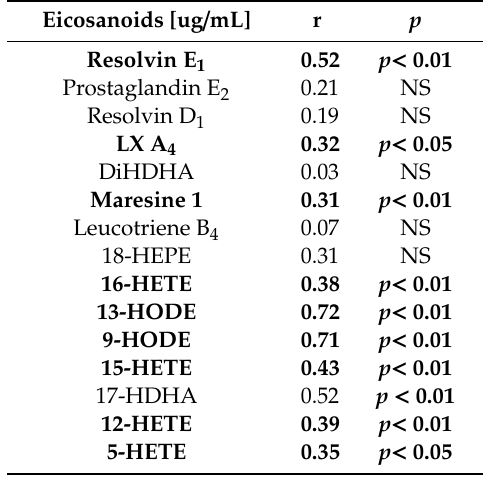
Table 4. Correlation of eicosanoids concentration between serum and liver tissue.